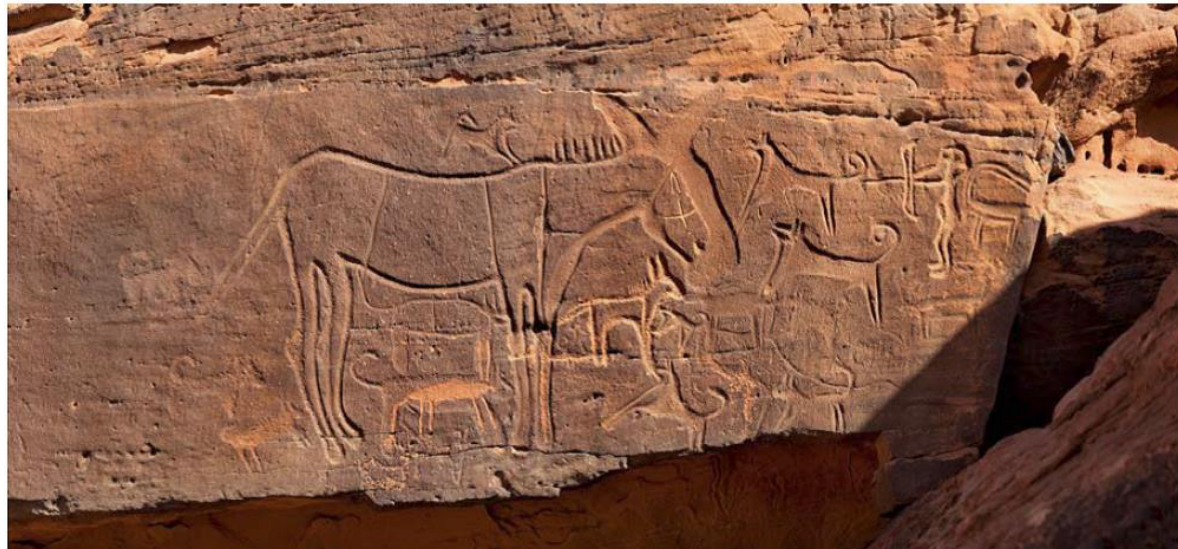
Figure 8. Assuming that this is a composition, it could be interpreted as attacking a wild donkey or other equid by bow and arrow and hunting with the help of dogs. Shuwaymis, northern